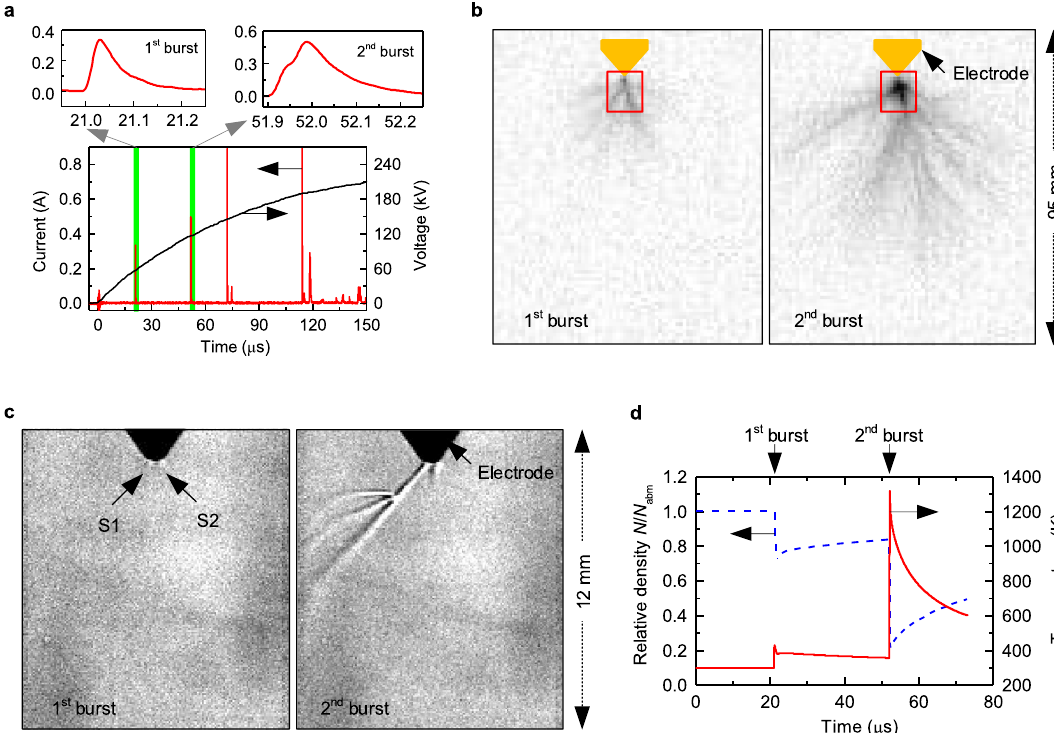
Figure 1. Typical results obtained in the experiment. ( a ) Current and voltage waveform, with the current pulses of the first two streamer bursts enlarged. ( b ) High-speed photograph frames of the morphology for the first and the second streamer bursts. The Schlieren observation area is indicated by the red box as reference. ( c ) High- speed Schlieren images of the stem channels formed by the first and the second streamer bursts. Images in ( b ) are colour inverted and those in ( c ) are contrast-enhanced. Frames between of these two bursts are displayed in the Supplementary Note 1. ( d ) Time variation of the stem density and temperature estimated from the measured current